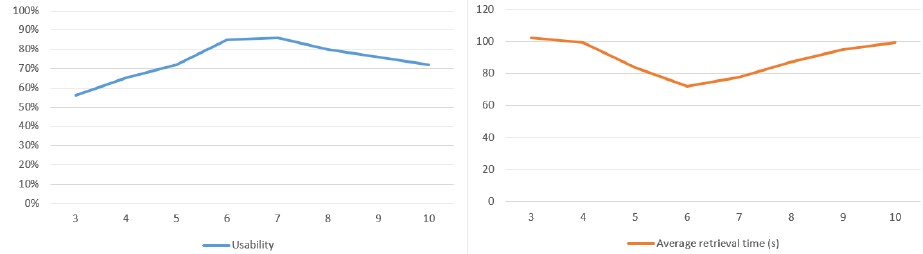
Figure 7. The depth of the ontological